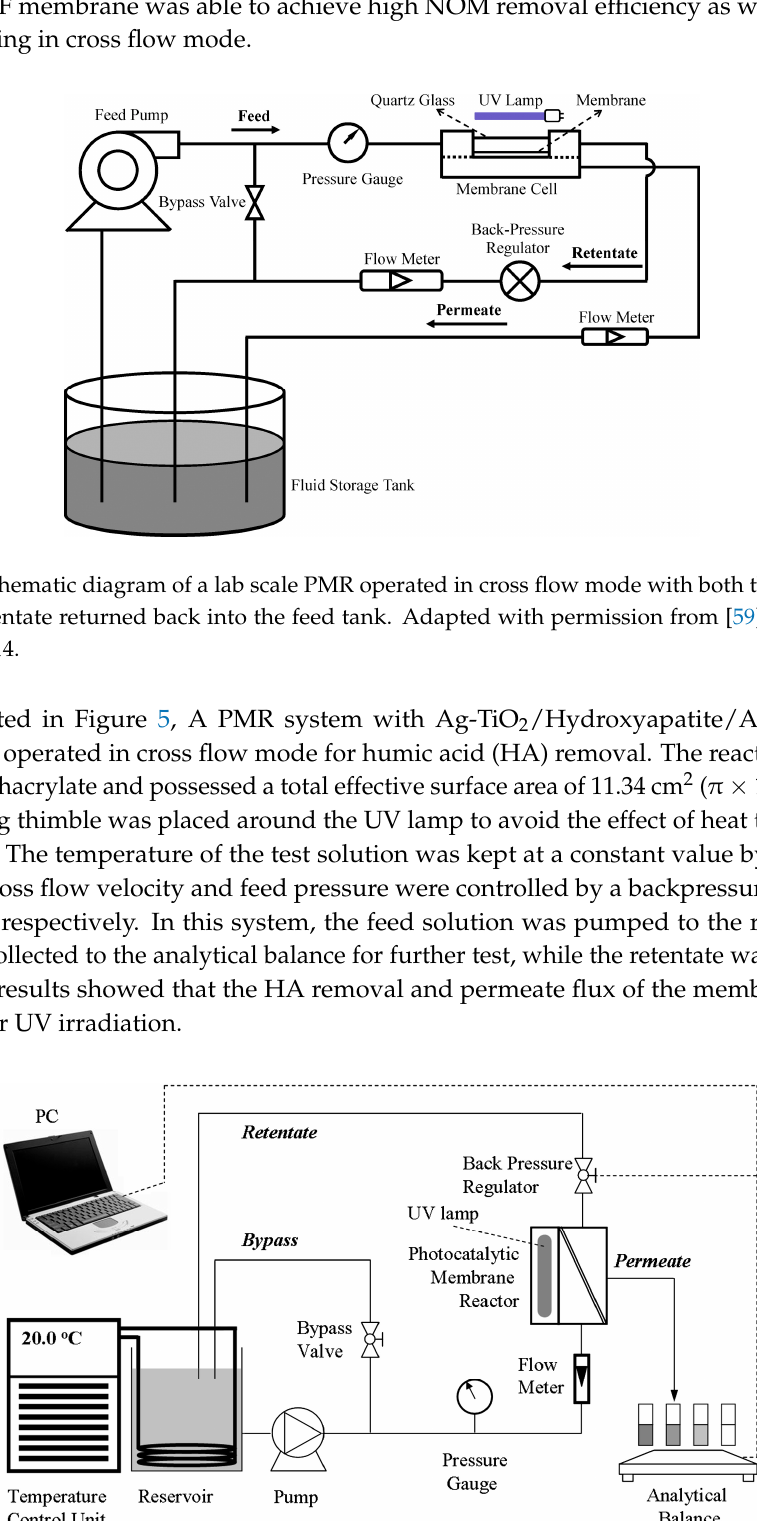
Figure 5. Schematic diagram of a lab scale PMR operated in cross flow mode with only the retentate returned back into the feed tank. Adapted with permission from [60], Copyright Elsevier, 2010.